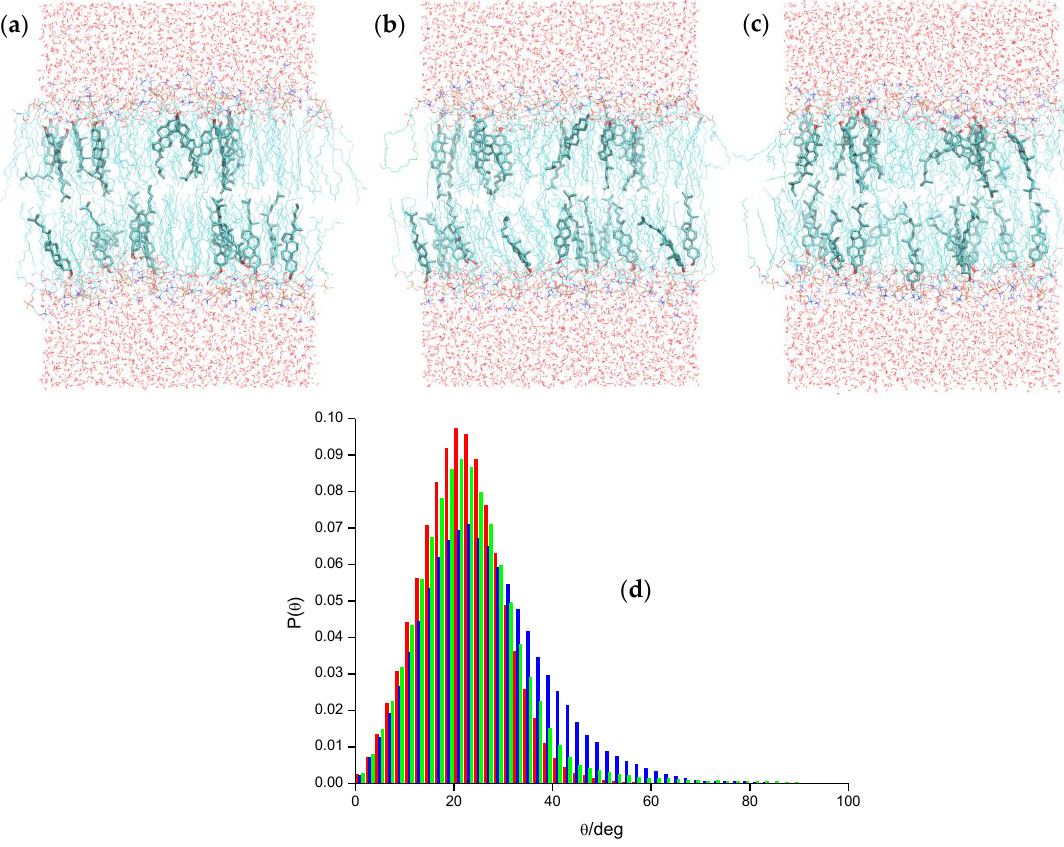
Figure 12. ( a – c ): Final structures obtained in the simulation of POPC bilayers with 20 mol% of ( a ) Chol, ( b ) CTL ( c ) DHE, respectively. Sterols are shown in thick lines, whereas water and POPC are displayed as thin lines. Cyan, blue and red colors are used for carbon, nitrogen and oxygen atoms, respectively (hydrogen atoms are not shown). ( d ) Probability density functions P ( θ ) of the angle between the sterol long axis and the bilayer normal for POPC / 50 mol% Chol (red bars), CTL (green bars) and DHE (blue bars). Adapted with permission from [149]. Copyright 2013 American Chemical Society.